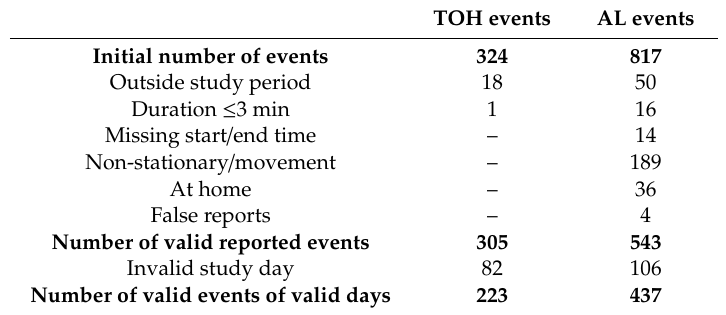
Table 2. Exclusion of self-reported TOH and AL events. Text in bold typeface indicates the main categories of retained events; plain text indicates categories of excluded events.